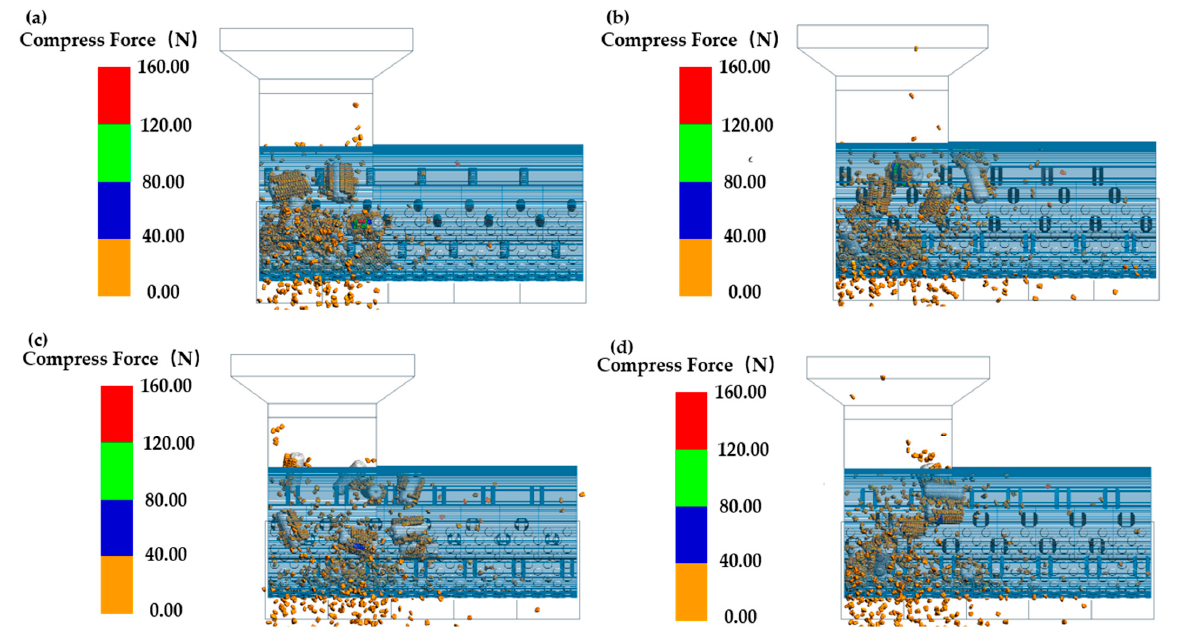
Figure 4. Dynamic simulation of the corn-threshing process at the threshing component width of: ( a ) 15 mm, ( b ) 20 mm, ( c ) 25 mm and ( d ) 30 mm.